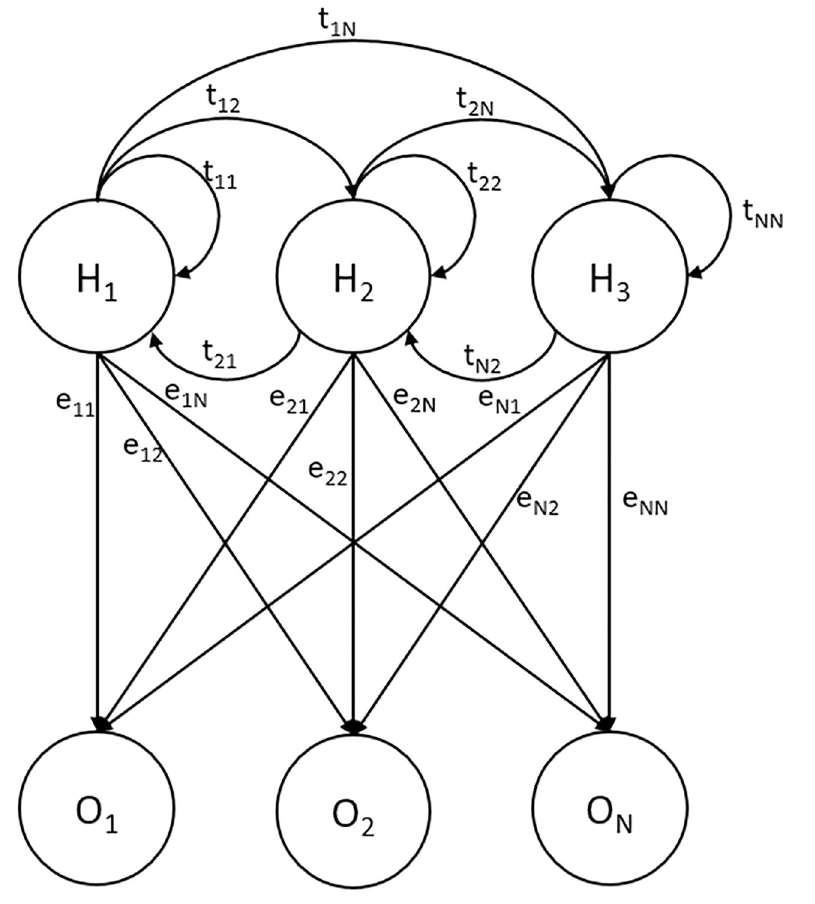
Fig 9. Hidden Markov